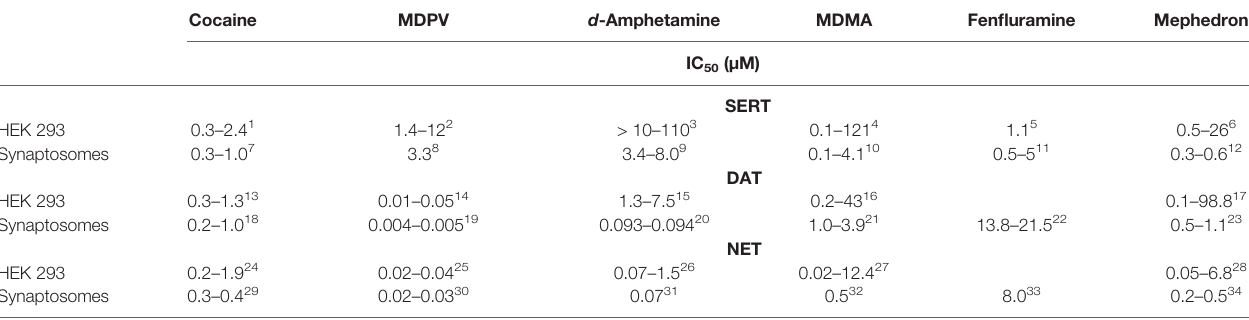
TABLE 1 | Range of previously reported IC 50 values for neurotransmitter uptake